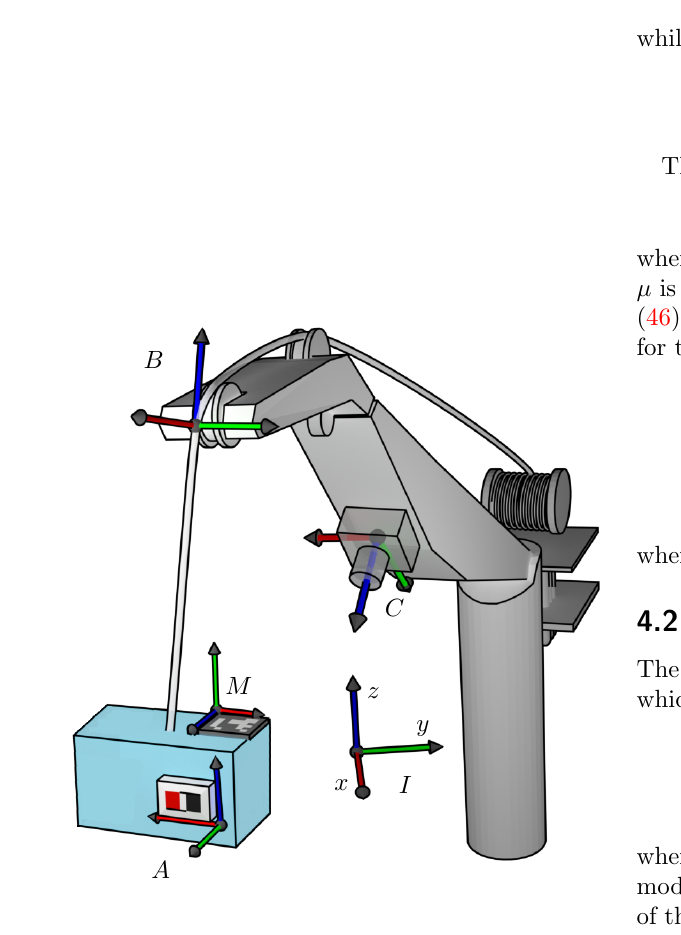
Figure 1: The objective is to estimate the motion of the body frame B with respect to the iner- tial frame I . The body frame B is fixed to the crane tip and rotates with the payload. A camera measures the orientation and posi- tion of the fiducial marker frame M with re- spect to the camera frame C . The IMU mea- sures the angular velocity and specific force in the IMU frame A with respect to the iner- tial frame I . The poses of the fiducial marker and the IMU, relative to the body frame B , are unknown static parameters that are esti- mated simultaneously with the motion of the